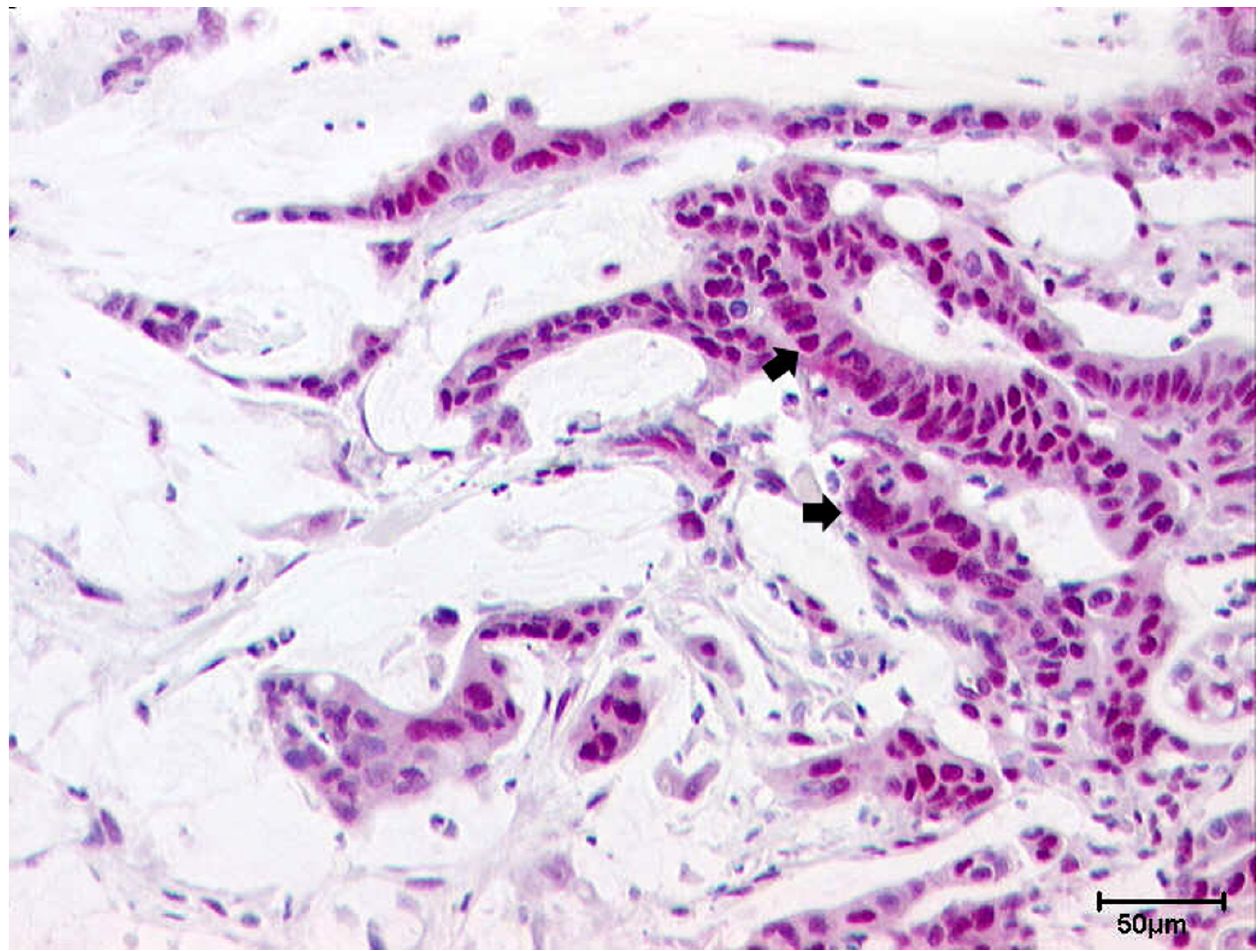
MLH1 staining Patient 0660-6: Mucinous adenocarcinoma of the colon with a strong nuclear staining (red staining product) of the tumor cells (arrows) for MLH1